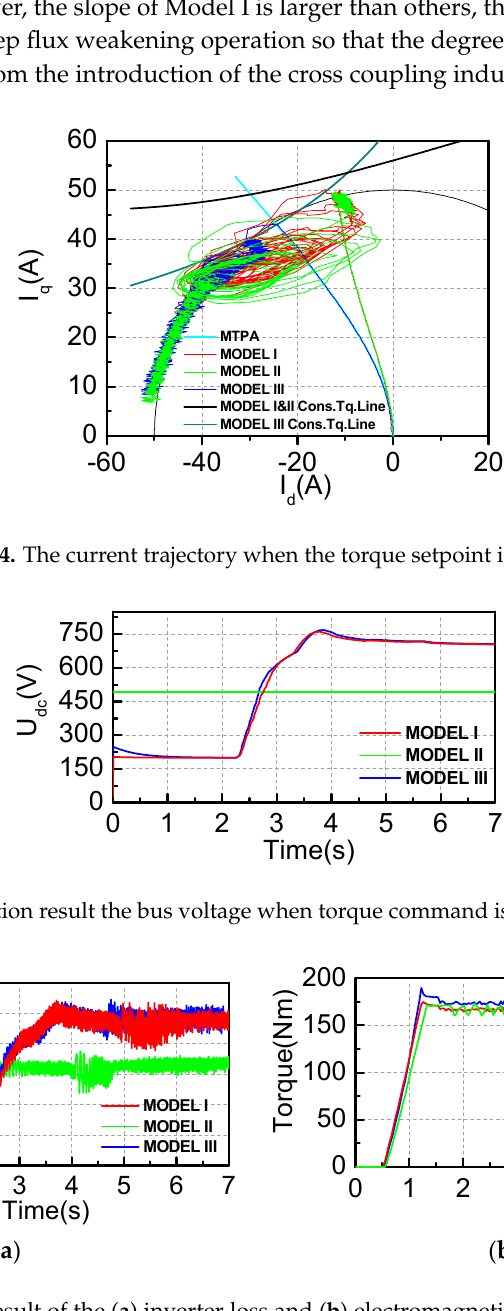
Figure 16. Simulation result of the ( a ) inverter loss and ( b ) electromagnetic torque when torque the command is limited at 190 Nm.